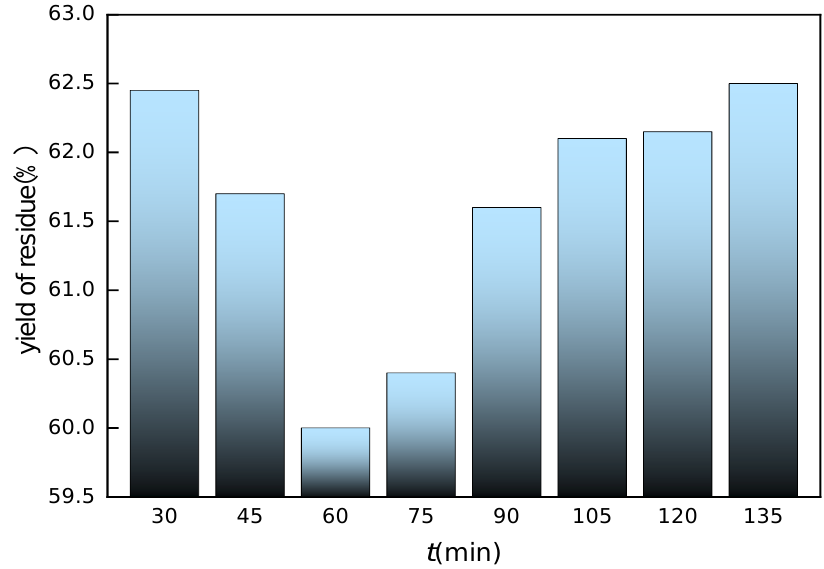
Figure 9. Effect of different calcination time on the yield of residue at 675 °C.